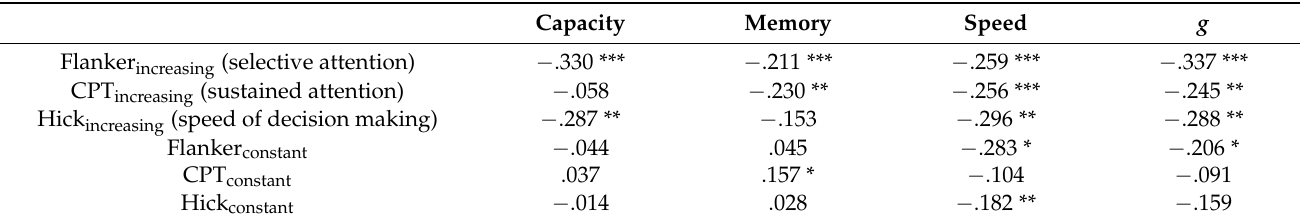
Table 2. Correlations between different aspects of intelligence (BIS-Capacity, BIS-Memory, BIS-Speed as well as the g factor extracted from these three aspects) and the latent variables derived from the flanker task, the continuous performance test (CPT) and the Hick task.